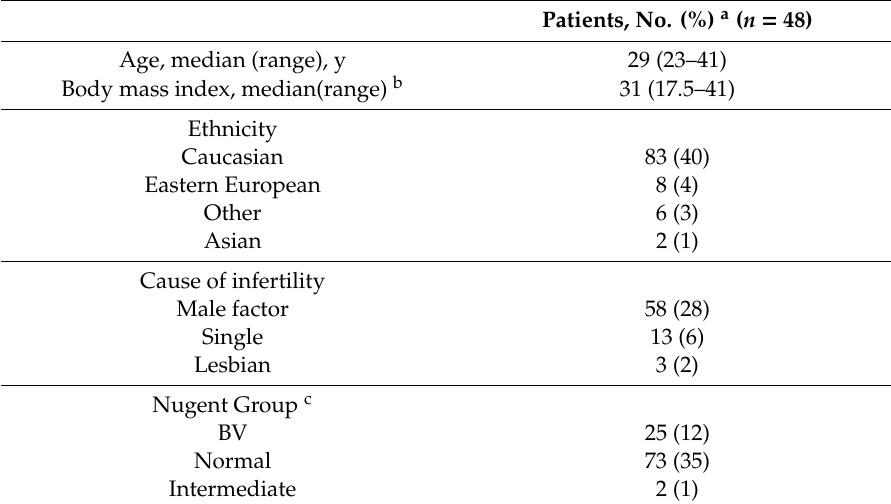
Table 1. Overview of the patient